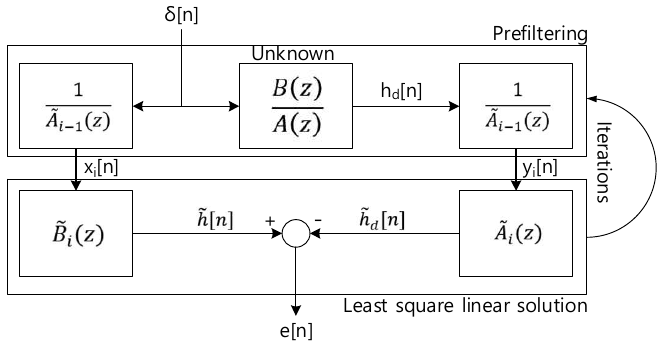
Figure 5. Modified system identification model for Stiglitz-McBride algorithm.